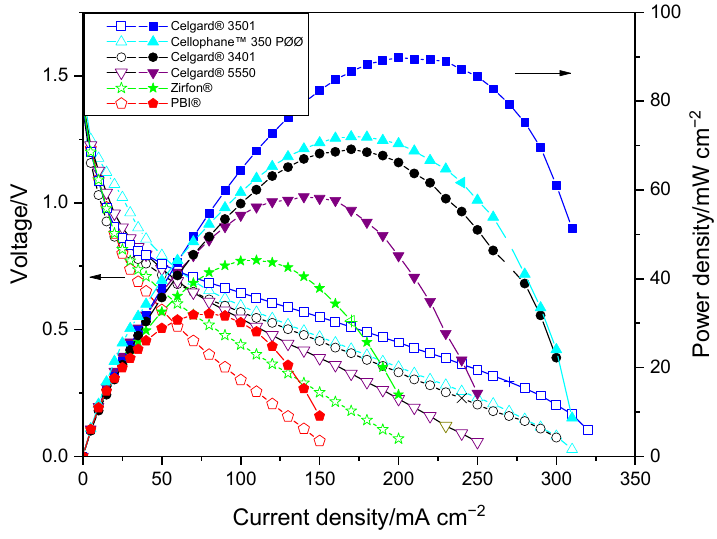
Figure 3 . Polarization characteristics of the Zn slurry–air flow battery with the different membranes.